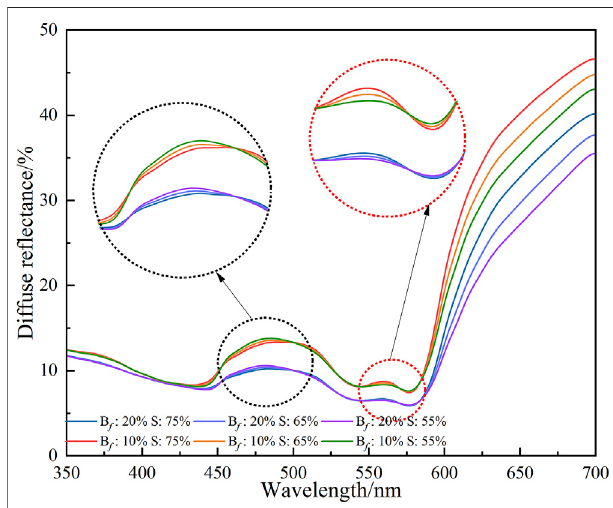
FIGURE 4 | The diffuse re fl ectances of more blood volume fraction and lower blood oxygen saturation. The blood oxygen saturation is 55%, 65%, and 75%, respectively. The blood volume fraction is 10% and 20%, respectively.